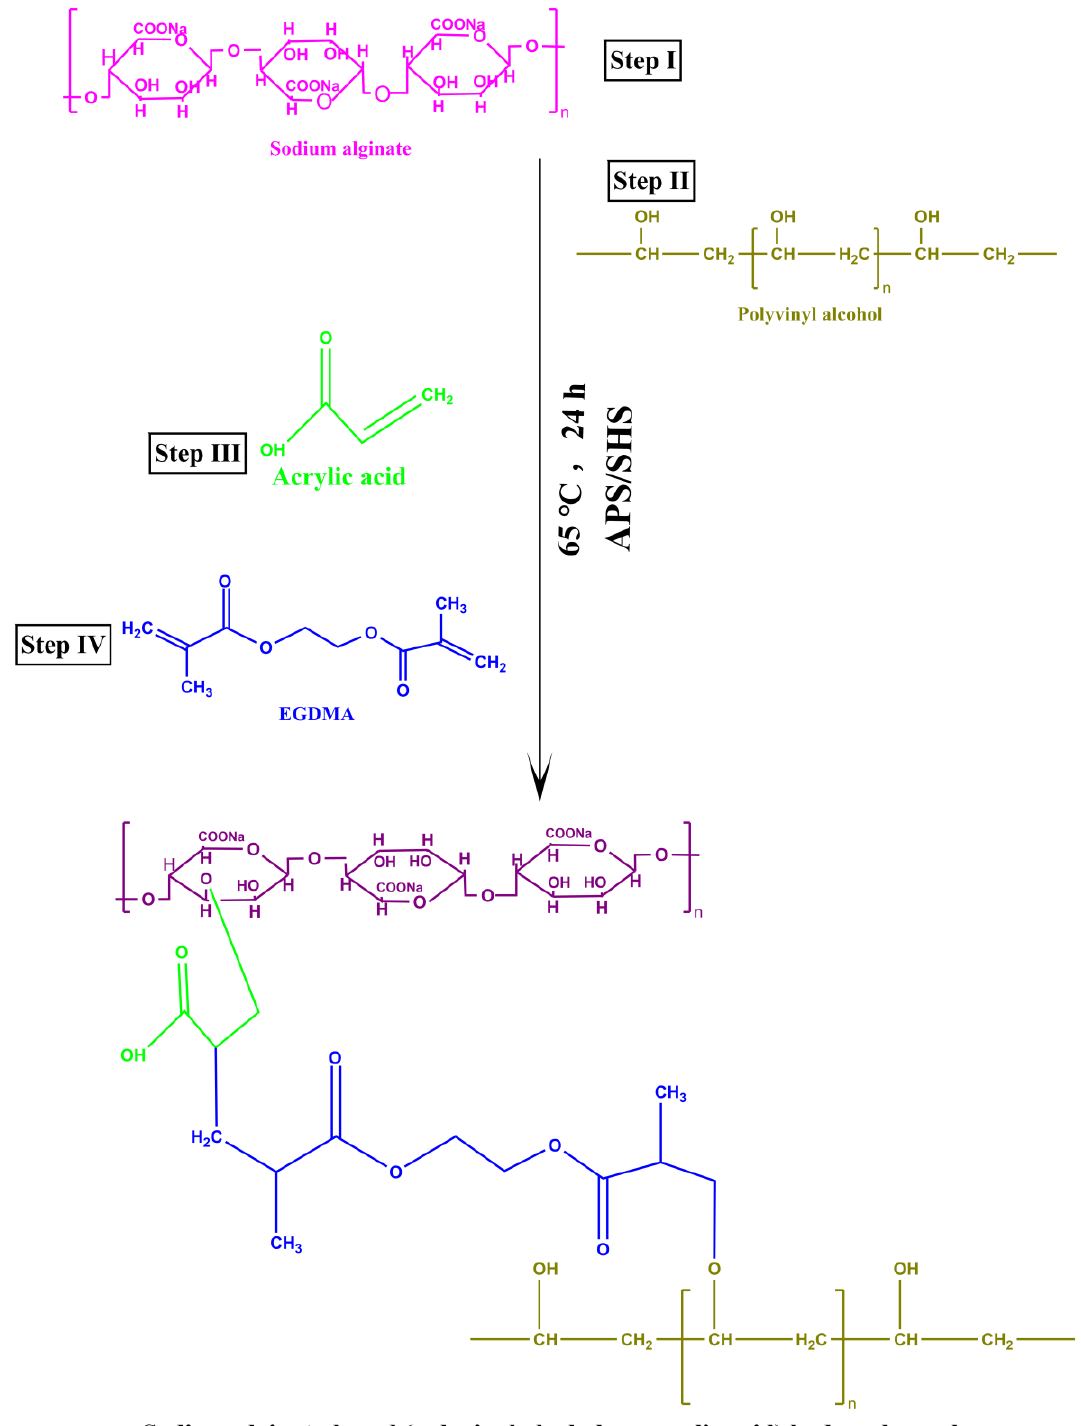
Figure 11. The proposed chemical structure of the synthesized sodium alginate based (PVA-co-acrylic acid) hydrogel membranes.